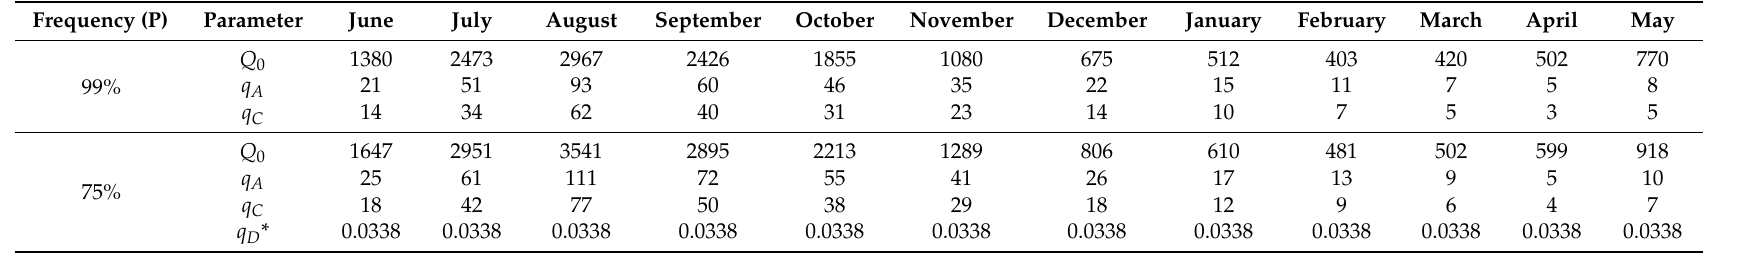
Table 1. Monthly water flow at di ff erent frequency levels (m 3 /